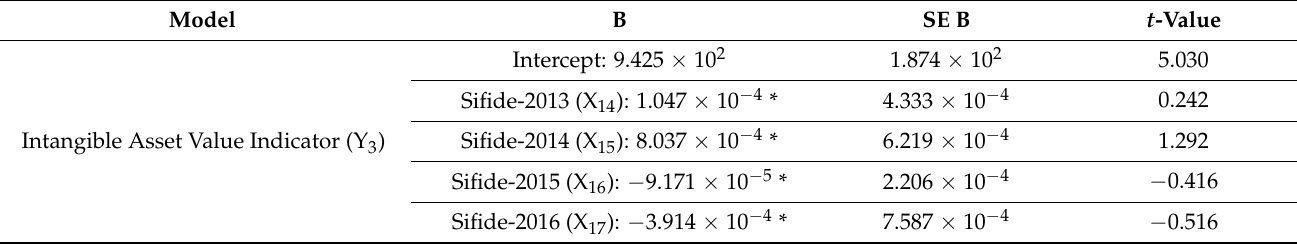
Table 5. Multiple Regression Result for Value Creation through Intangible Assets. Model B SE B t -Value